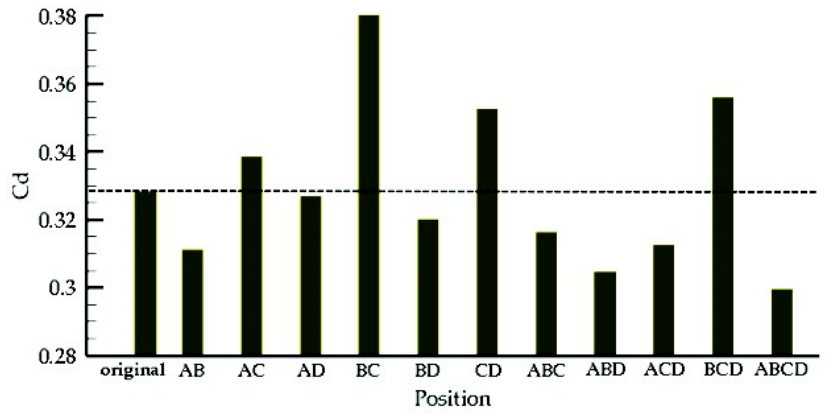
Figure 13. The influence of different combination conditions on the drag coefficient (15 kV).